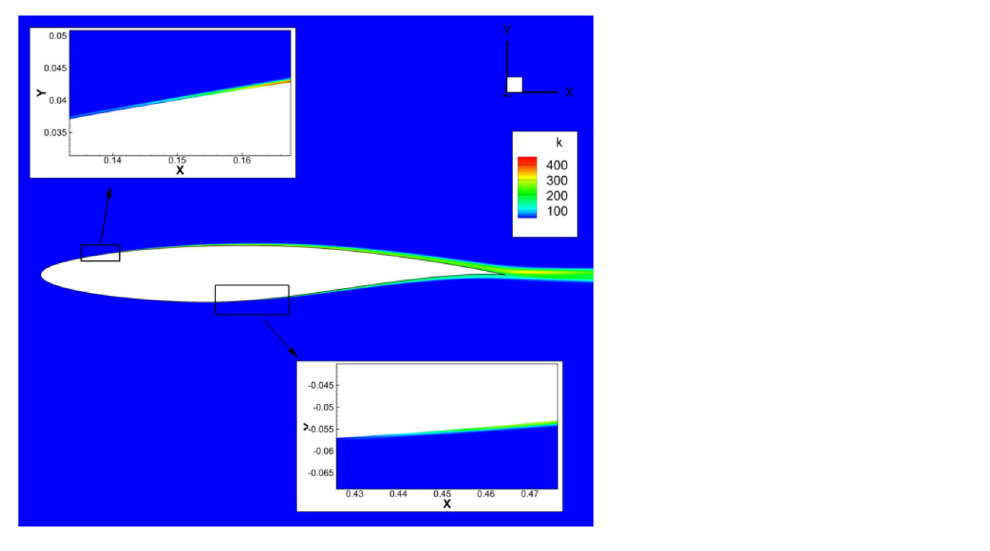
Figure 4. Kinetic energy k distribution